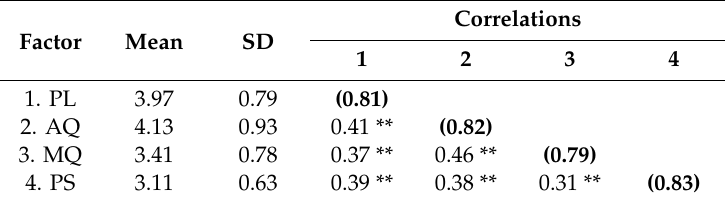
Table 1. Descriptive statistics, correlations and discriminant validity.